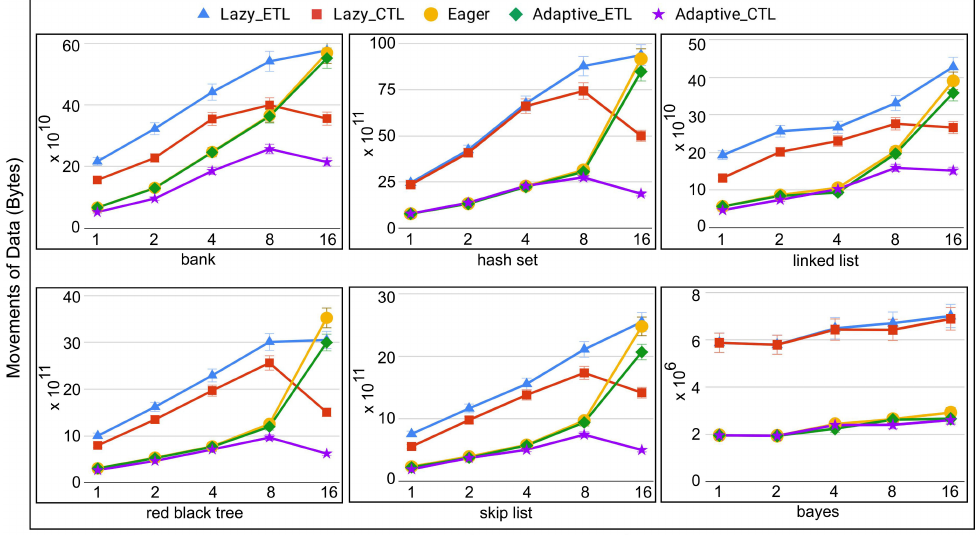
Figure 7. Data movements in micro-benchmarks and bayes from STAMP executing in persistent TM.